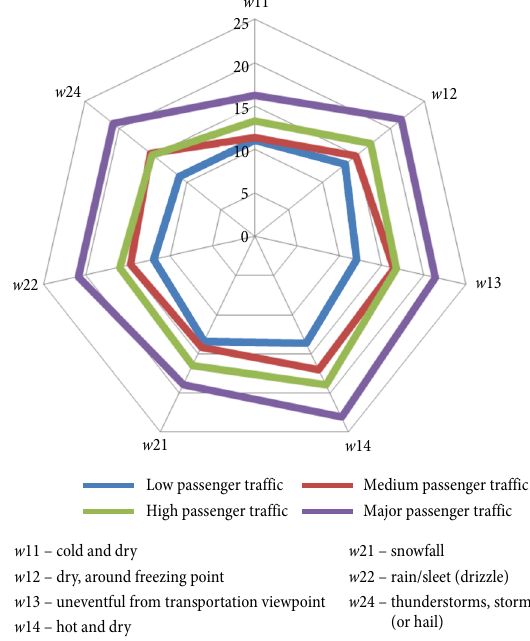
Fig. 3. Mean values of dwell times [s] at stops according to the volume of passenger-traffic and weather categories ( source : research by the Table 6. Mean values and standard deviation of dwell times [s] at stops according to weather categories ( source : research by the authors) Weather category and its notation w j